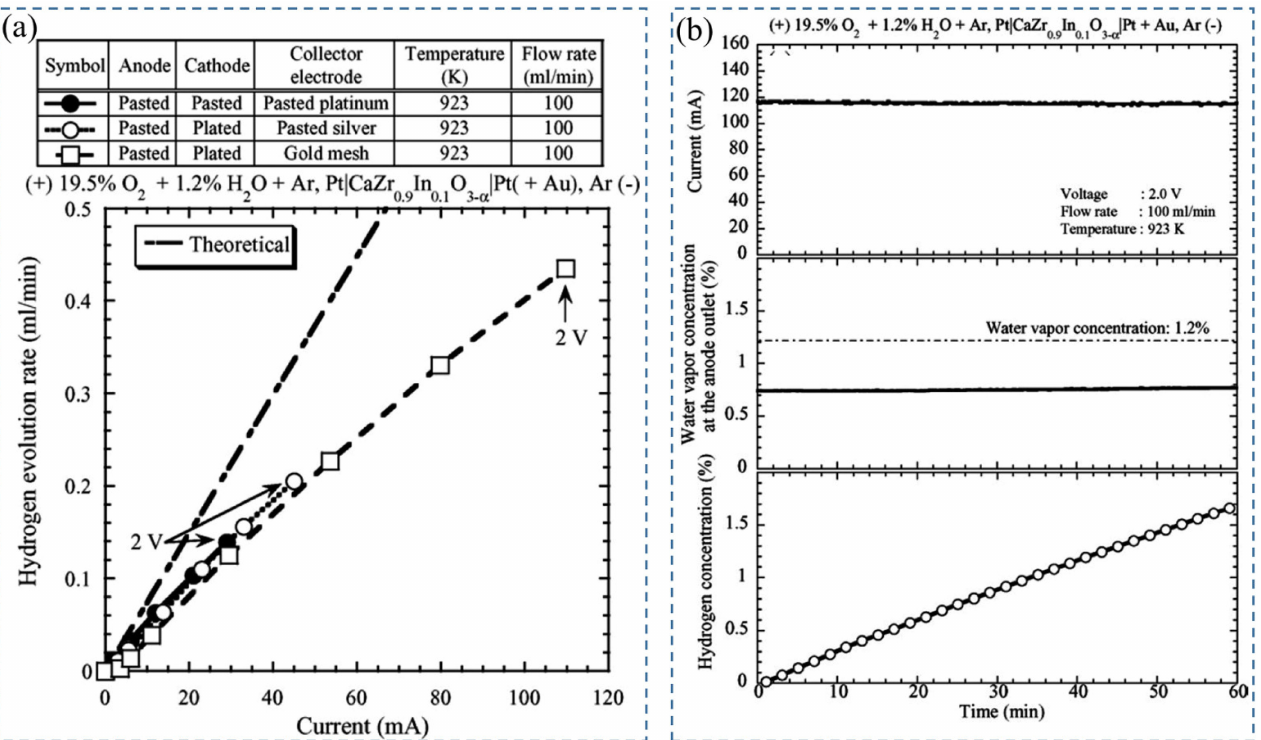
Figure 4. ( a ) Change in hydrogen evolution rate with time for different electrode combinations, ( b )Time series response of current (top panel), water vapor concentration at the anode outlet (middle panel), and hydrogen concentration (bottom panel) against enrichment characteristics. Reprinted with permission from Ref. [71]. Copyright 2006